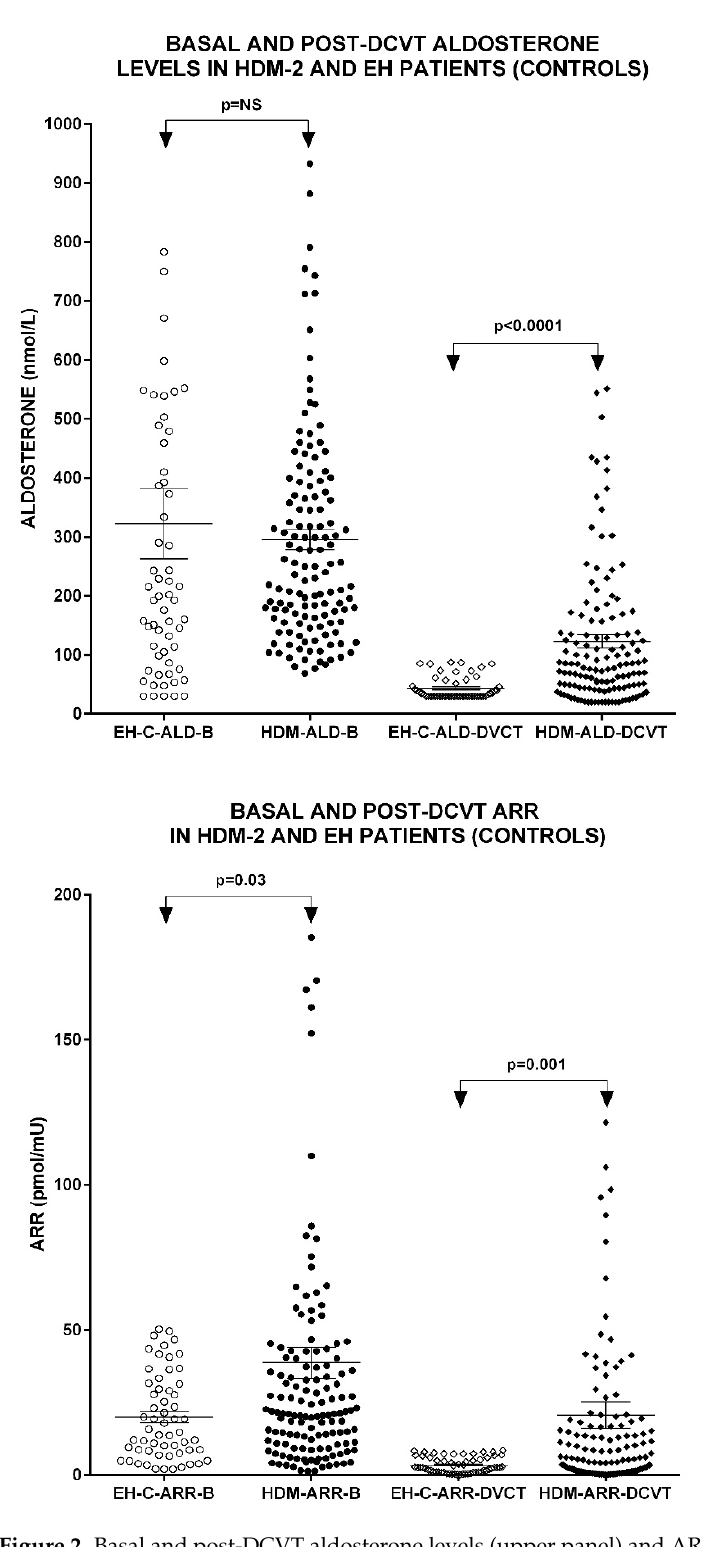
Figure 2. Basal and post-DCVT aldosterone levels (upper panel) and ARR (lower panel) in DM-2 and EH patients. EH: essential hypertensive patients. HDM: hypertensive diabetes mellitus patients.